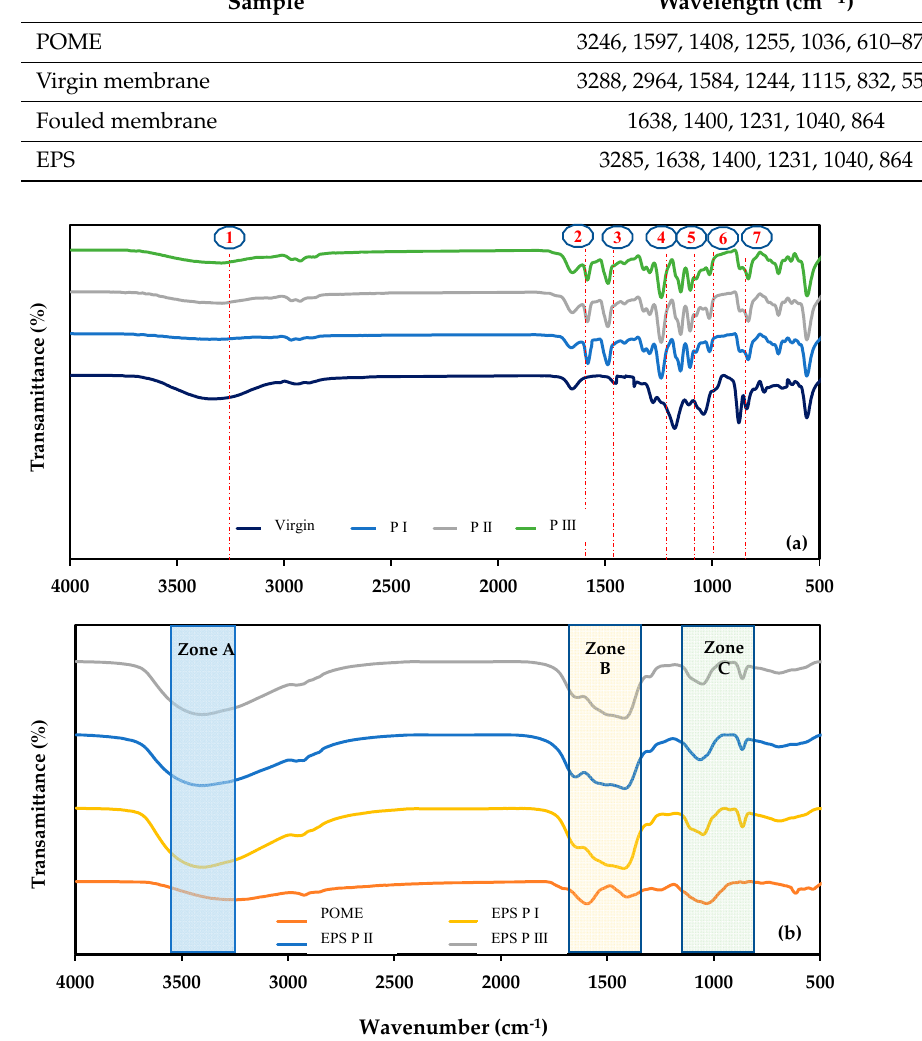
Figure 5. FTIR spectra of ( a ) virgin and fouled membranes and ( b ) POME and EPS in each period. Table 3. Summary of FTIR spectra peak assigned for the samples.